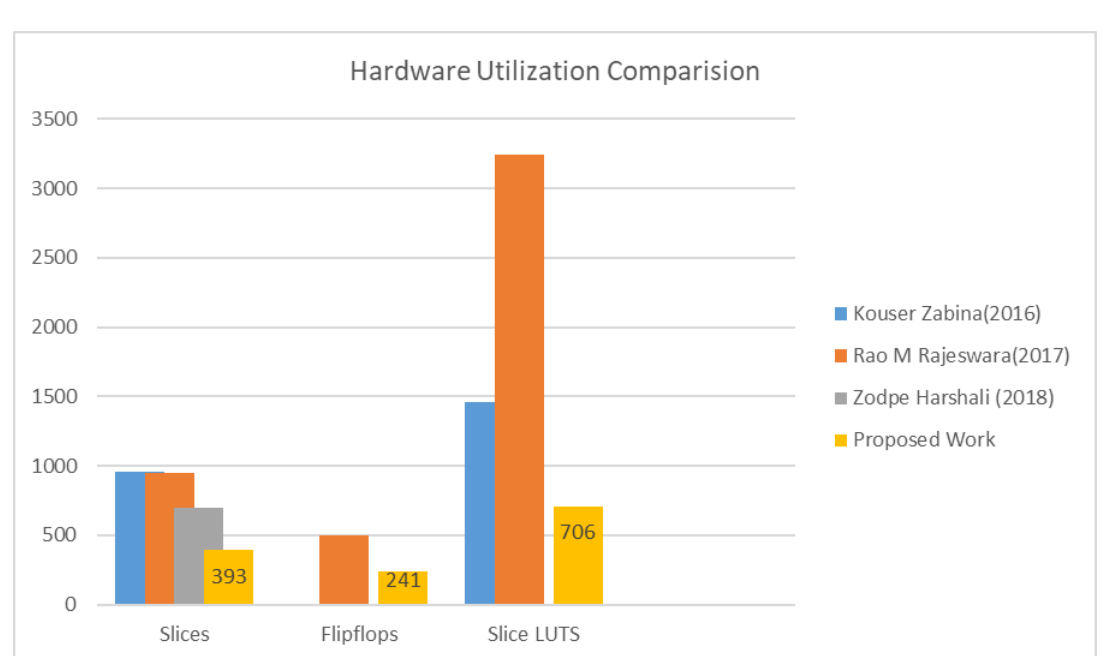
Figure 8 Comparative hardware utilization graph of TACIT algorithm with existing AES